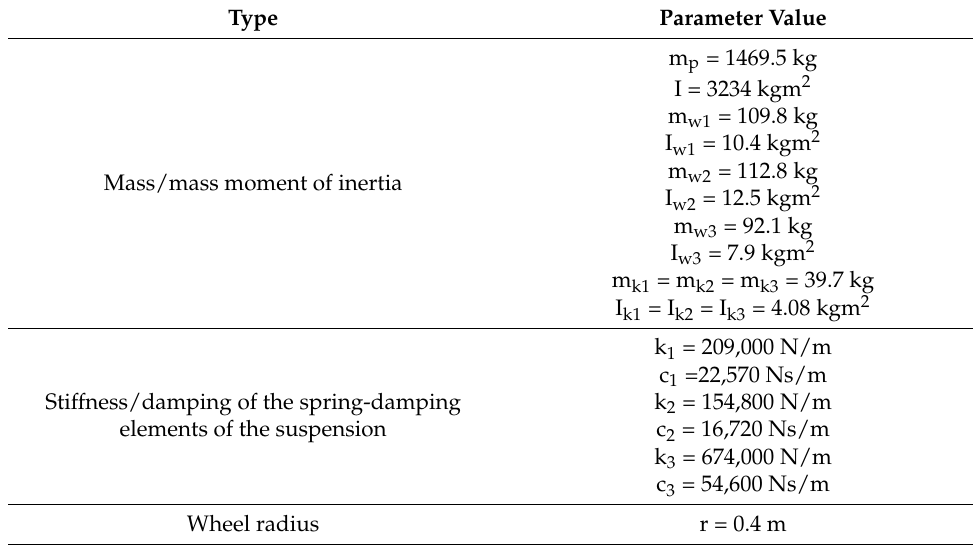
Table 1. Values of main vehicle body parameters.